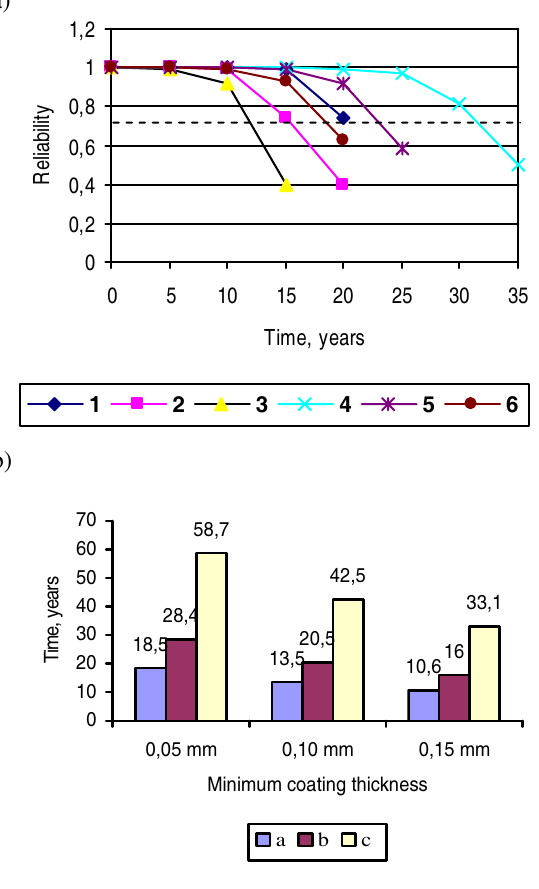
Admissible coating thick- ness, d min